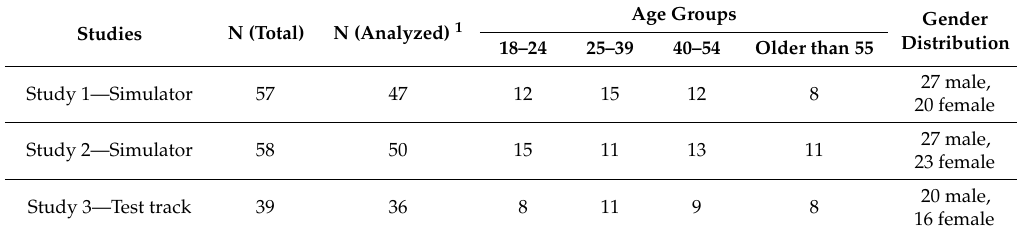
Table 3. Number of participants, age, and gender distributions of participants per